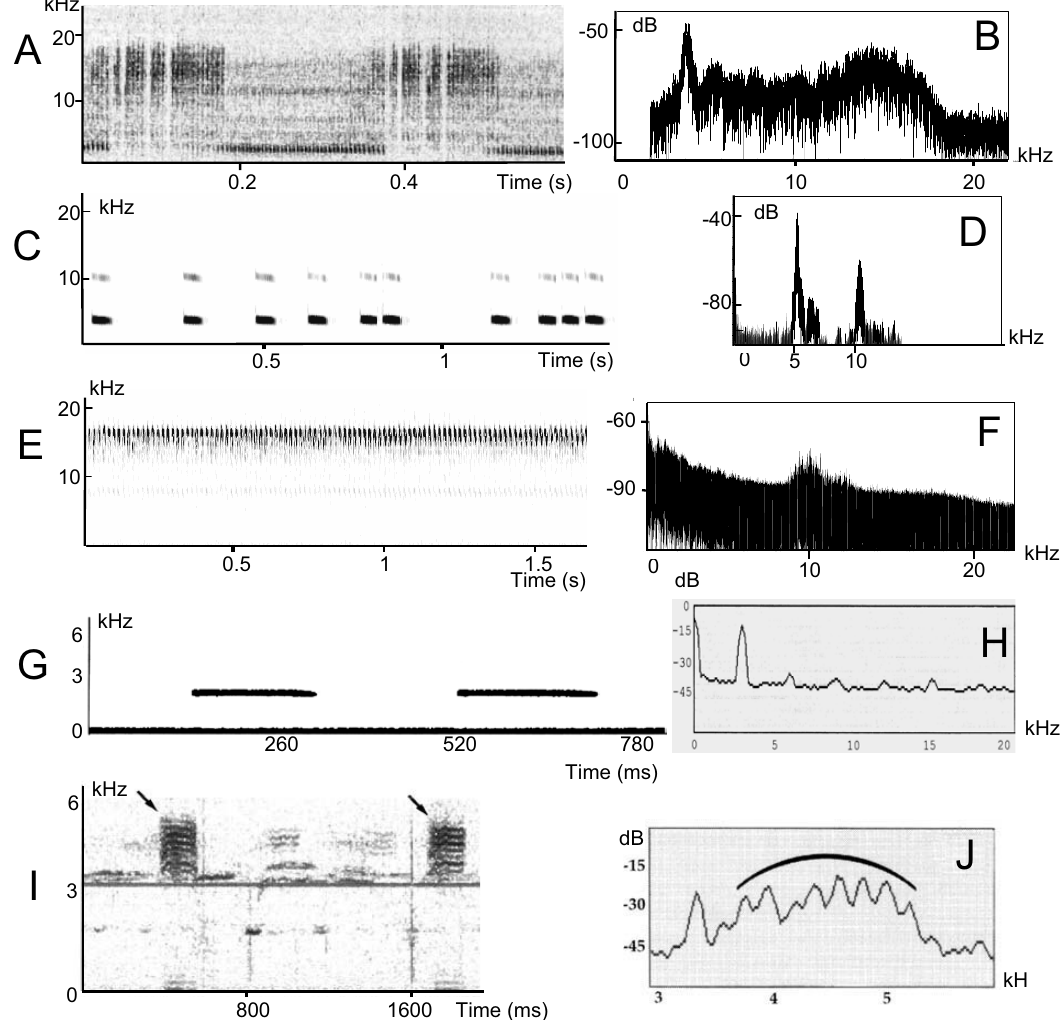
Fig. 1 – Diversity of cricket advertisement signals. Spectrogram and power spectrum of Eneoptera surinamensis (A, B), Xenogryllus marmoratus (C, D), Agnotecous yahoue (E, F), Paragryllodes campanella (G, H) (modified from Desutter-Grandcolas 1998b), and Orocharis fulvescens (I, J) (modified from Desutter-Grandcolas and Bland